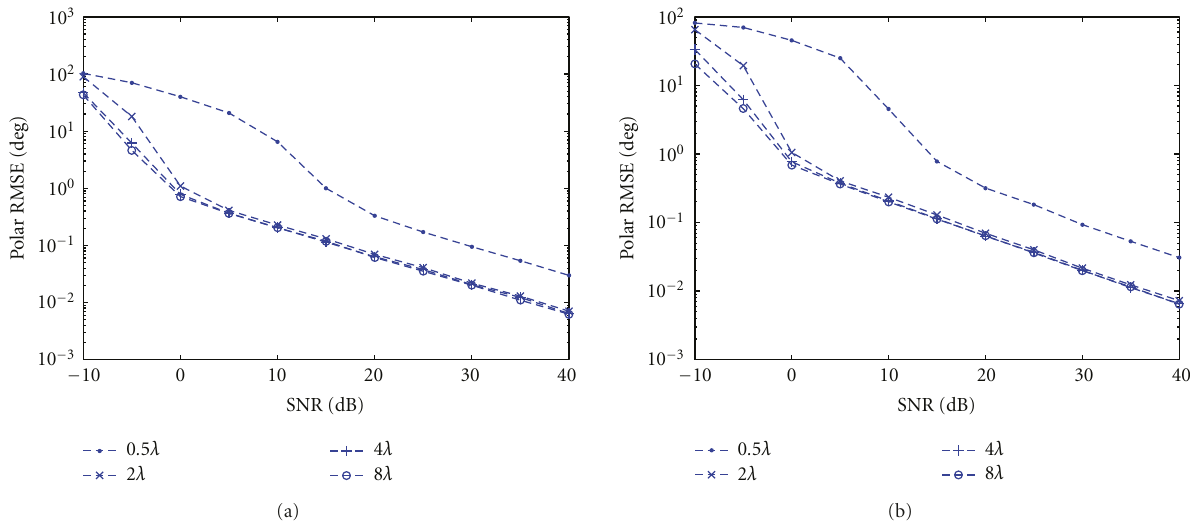
Figure 2: Polarization state estimates RMSE of the proposed EVSA-PM against SNRs. (a) Source 1, (b) source 2.